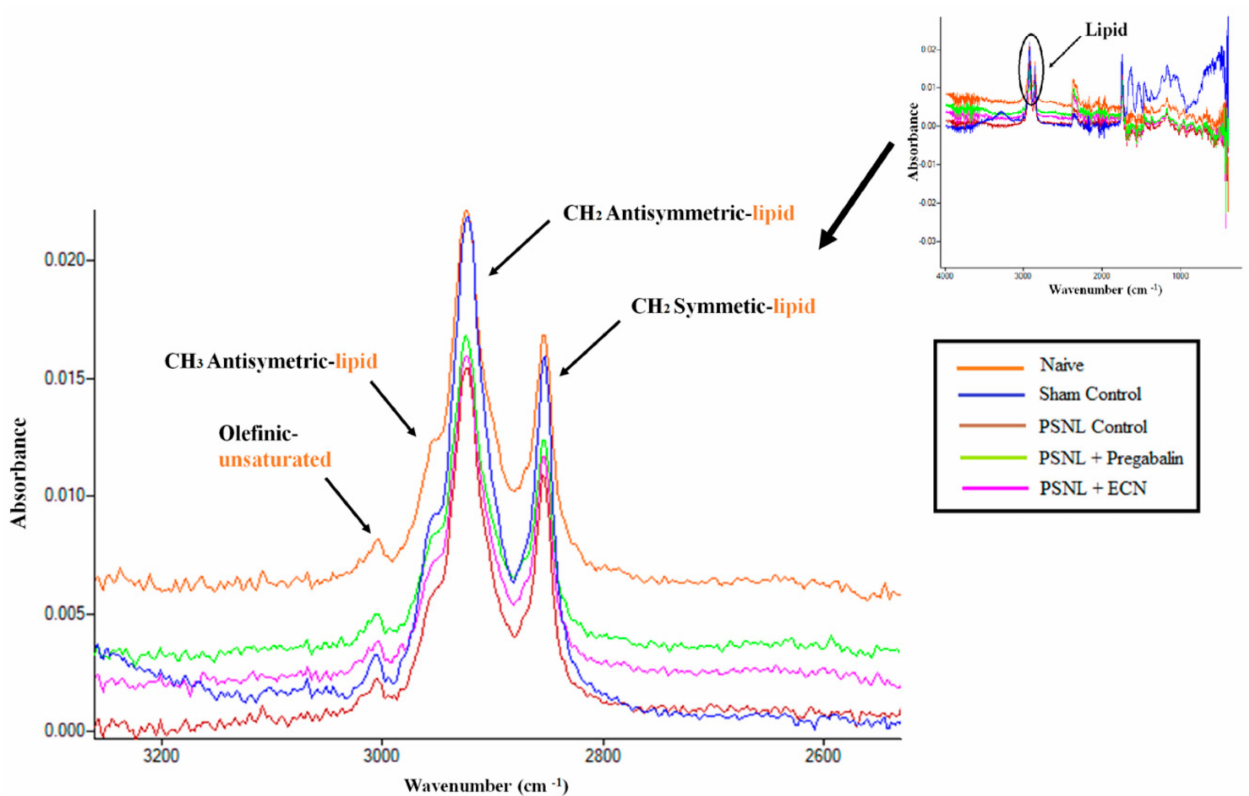
Figure 11. Effects of ECN (10 mg/kg) on the lipid content of the sciatic nerve. The FTIR spectra of the naive, sham control, PSNL control, PSNL + pregabalin and PSNL + ECN treated sciatic nerve in the range of 3025–2800 cm − 1